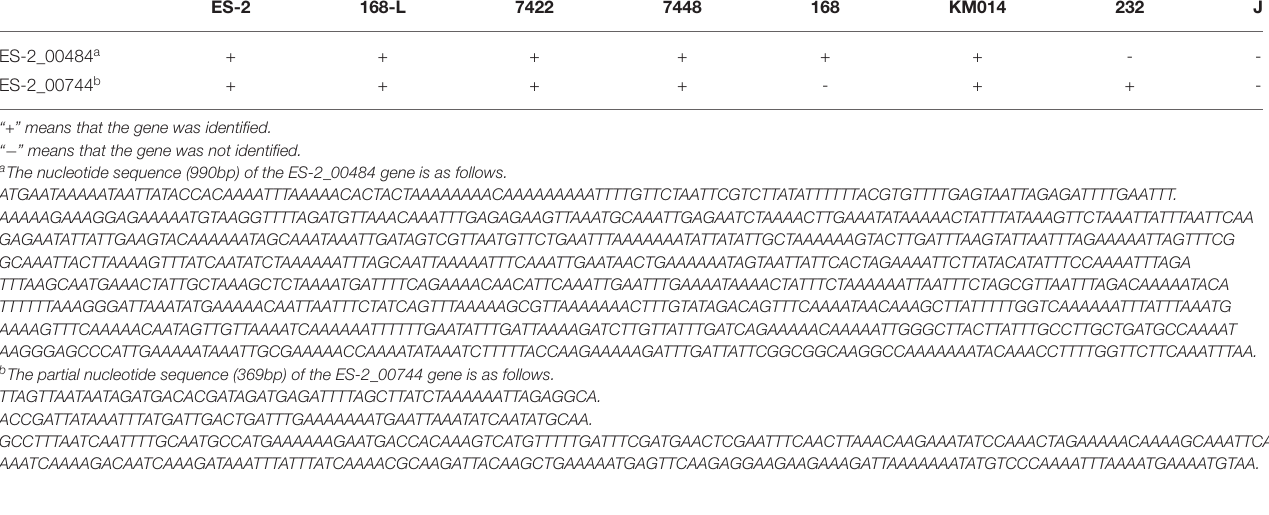
TABLE 2 | The gene present in pathogenic M. hyopneumoniae strains but absent in nonpathogenic M. hyopneumoniae strain at the nucleotide level.